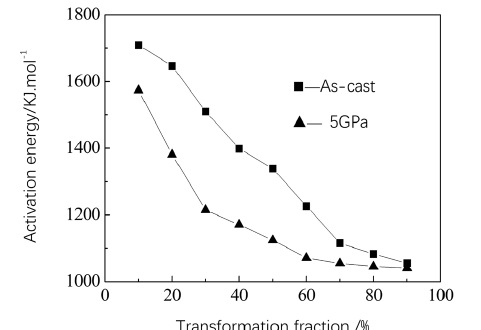
Fig. 8 - Relationship between the phase transformation activation energy and the phase transformation volume fraction of Cu-Al alloy before and after high pressure treatment